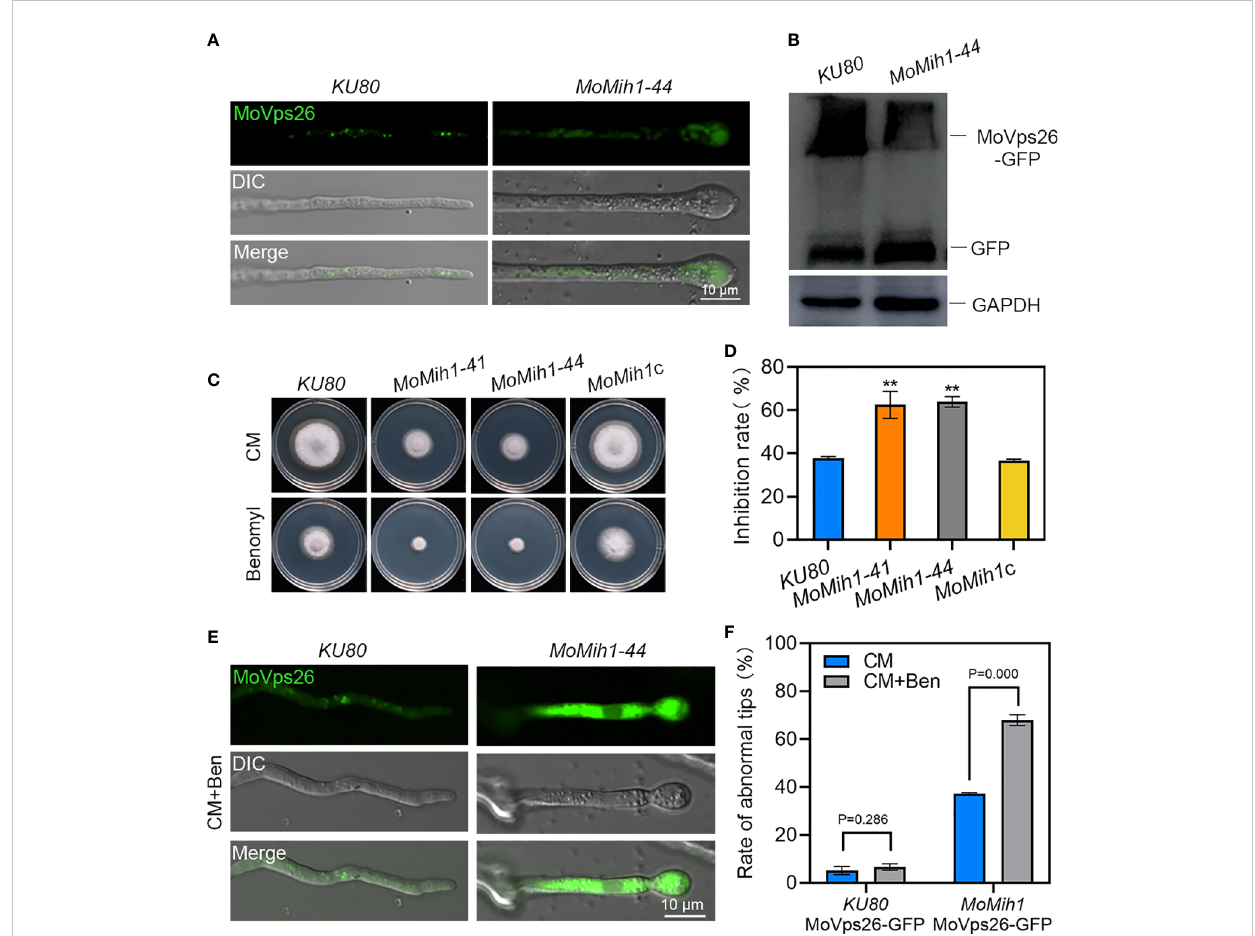
FIGURE 9 MoMih1 is required for the localization of MoVps26 in M. oryzae . (A) The localization of MoVps26-eGFP in MoMih1 mutants. The strains KU80 and MoMih1-44 were respectively expressed the MoVps26-eGFP fusion protein, and then hyphal tips of resultant transformants were examined under confocal microscopy. The localization of MoVps26-eGFP was abnormal in the swollen tips of the MoMih1 mutants. Bar = 10 m m. (B) The proteolysis of MoVps26-eGFP has increased in the MoMih1 mutant. Mycelia of KU80 and MoMih1-44 expressing MoVps26-eGFP were cultured in liquid CM at 28°C for 36 h, and the MoVps26-eGFP fusion protein was detected by immunoblotting with anti-GFP. The blotting of GAPDH was used as a control. (C) Mycelia growth under benomyl treatment. All tested strains were inoculated on CM supplemented with 0.4 m g/mL benomyl and cultured at 28 °C for 5 days. (D) Statistical analysis of the inhibition rate under benomyl treatment. “ ** ” represents the signi fi cant difference between KU80 and MoMih1 mutants (p < 0.01), and Error bars represent SD. (E) Localization of MoVps26-eGFP under the treatment with 0.4 m g/mL benomyl. The strain MoMih1 /MoVps26- eGFP was inoculated in liquid CM at 28°C for 24 h in darkness, then added with benomyl and grew at 28°C for 16 h in darkness. Bar = 10 m m. (F) Treatment of benomyl stimulated the formation of swollen structures in the MoMih1 mutants. The swollen structures of the KU80 /MoVps26-eGFP and MoMih1 /MoVps26-eGFP was recorded by amending with or without benomyl, and the rate of abnormal mycelial tips was statistically analyzed. The error bars represent the SD of three replicates, whereas “ ** ” represents a signi fi cant difference ( p <